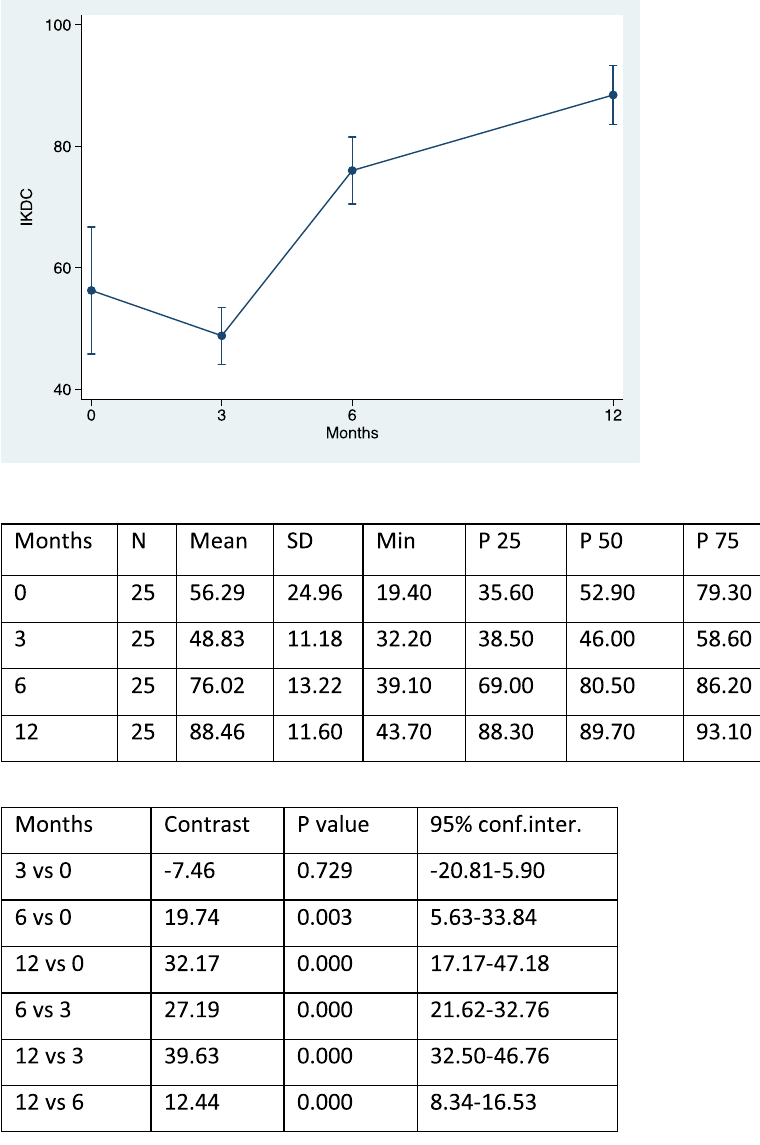
Table 3 IKDC scores at the different follow up and comparison between each